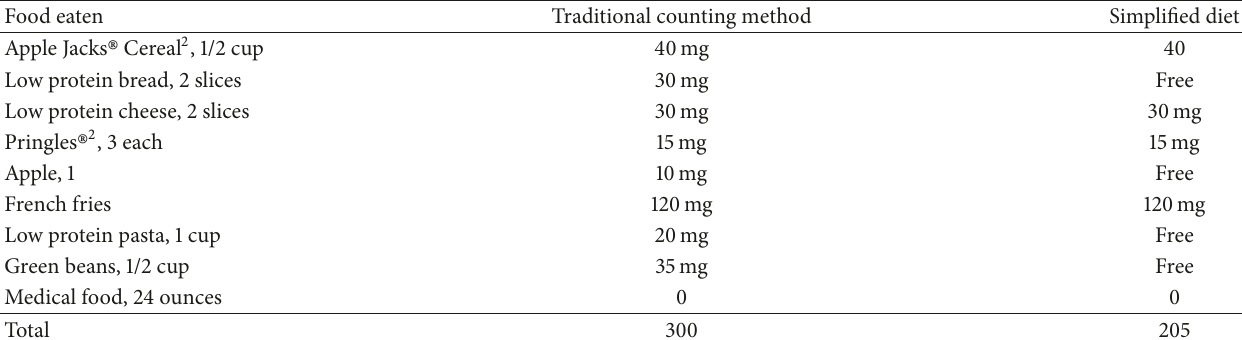
Table 1: Example of counting phenylalanine using the traditional counting method and the Simplified Diet 1 . Food